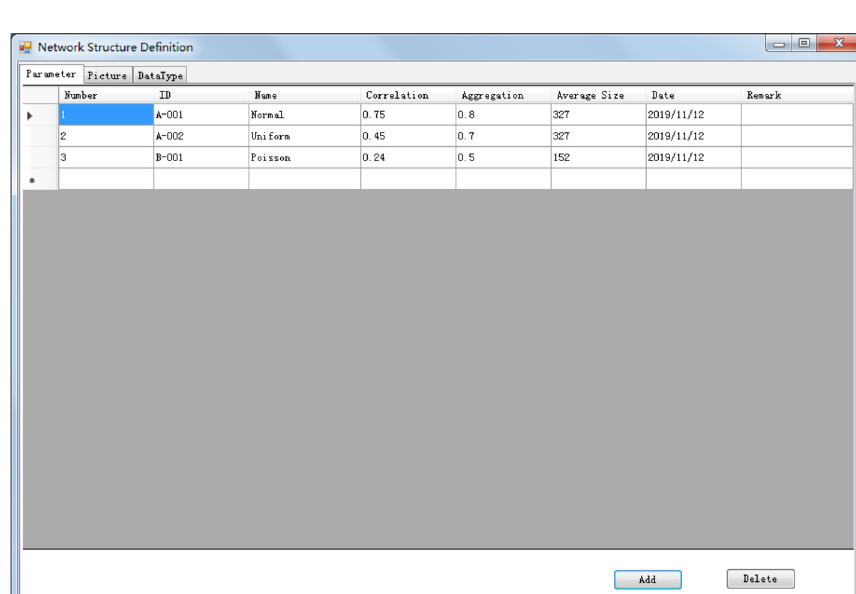
Figure 10. Network structure general attribute de fi nition